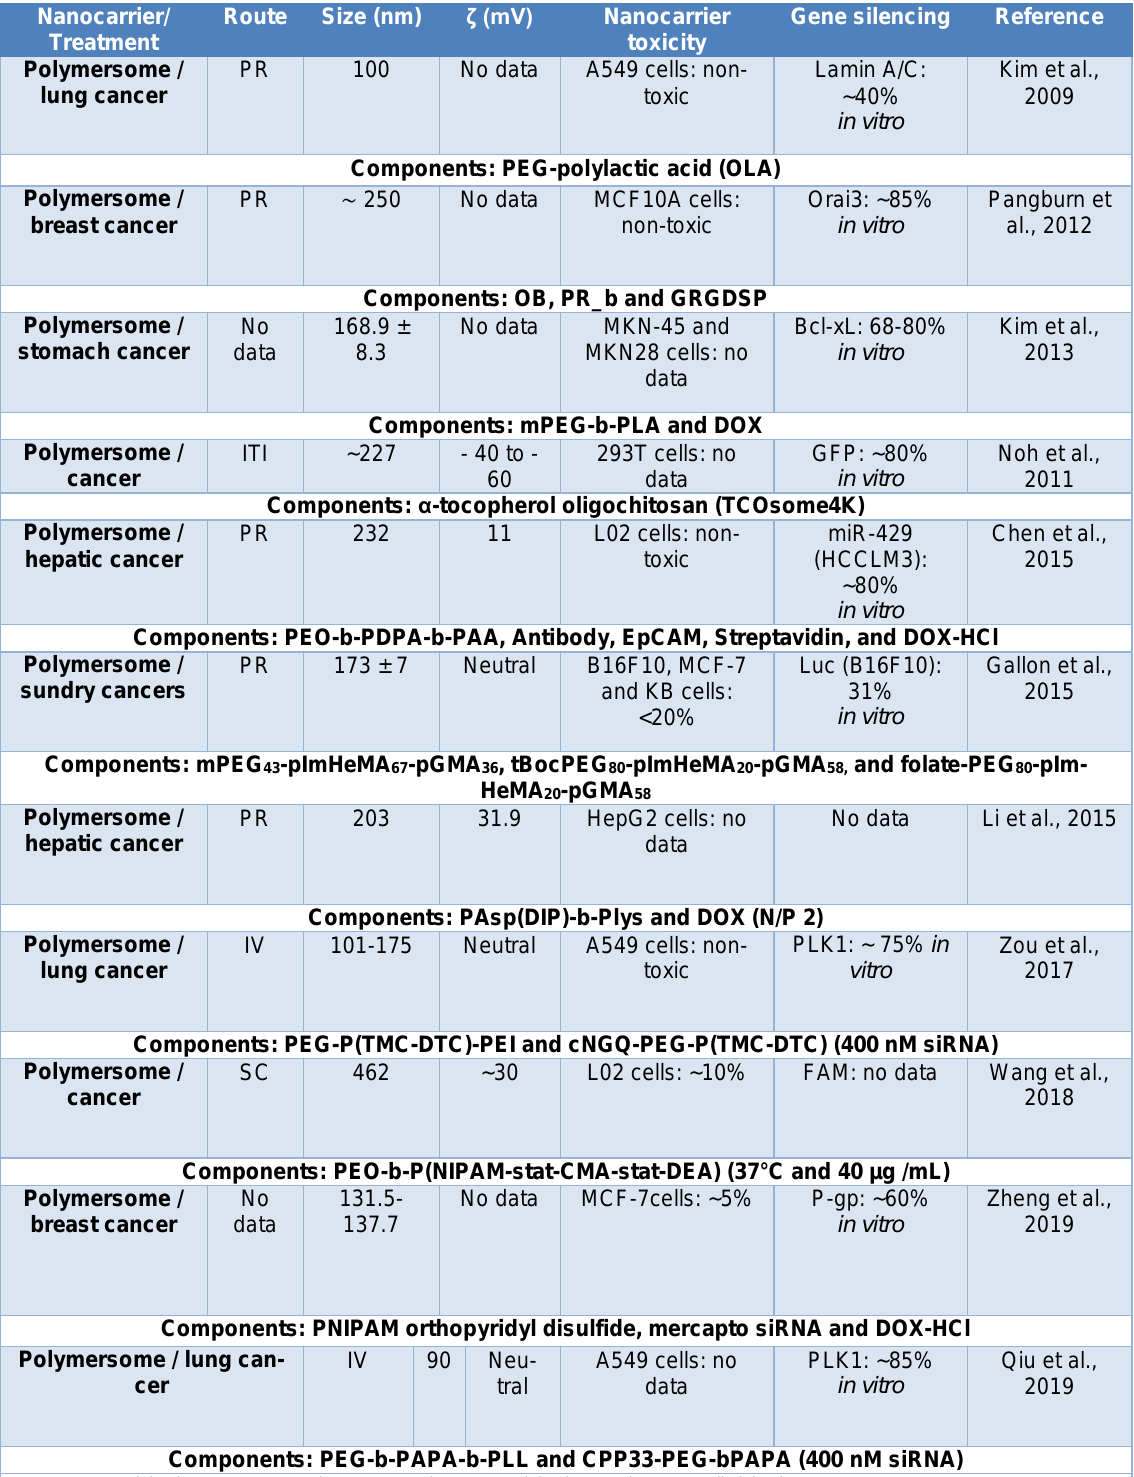
Table 2: Nanocarriers composed of polymeric